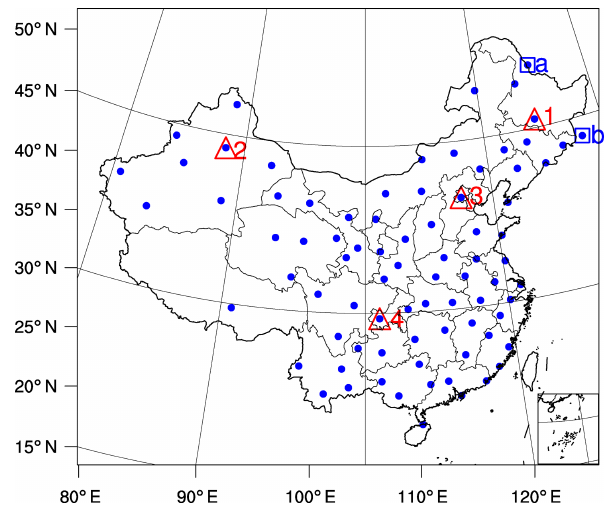
Figure 1. Distribution of the observation stations. The triangles in- dicate the four stations selected to discuss seasonal variations in air stagnation in Sect. 3: 1 is Harbin, 2 is Urumchi, 3 is Beijing, and 4 is Chongqing. The squares indicate the two stations outside of China at Blagoveshchensk (a) and Vladivostok (b)